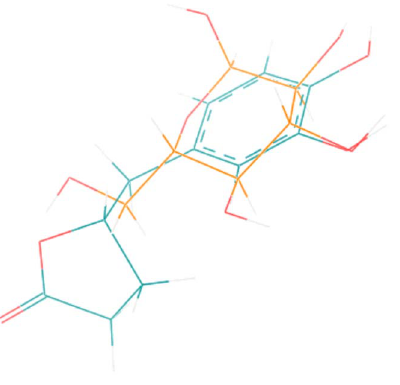
Figure 4. Structural alignments of M1 and glucose. The S-isomer of the metabolite M1 ( d -(3,4-dihydroxy-phenyl)- c -valerolactone; blue) and glucose (yellow). The calculations were performed with SYBYL-X H (Tripos, version 1.0).